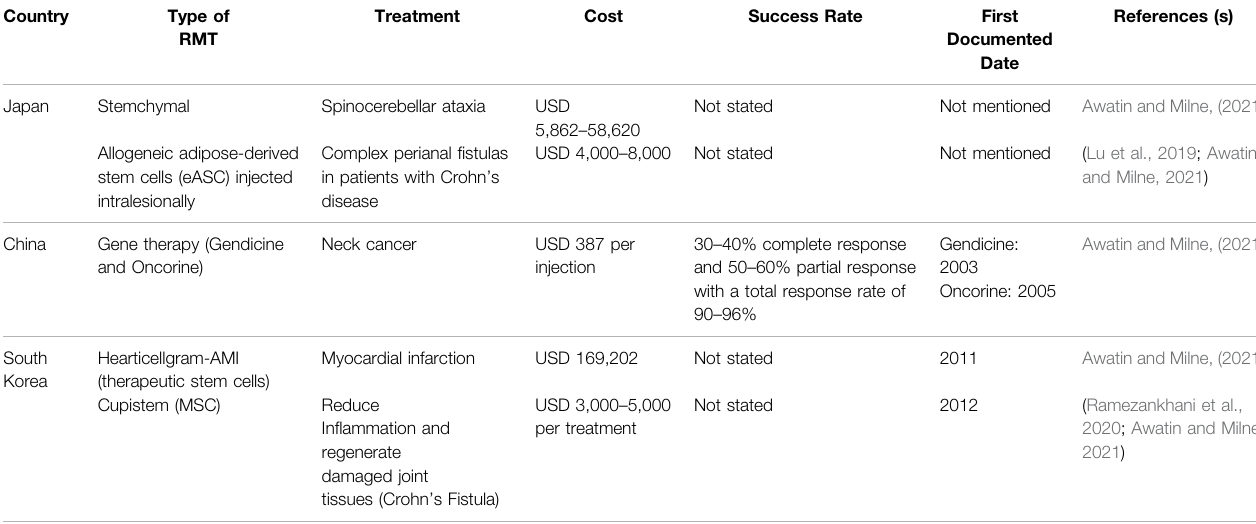
TABLE 1 | Regenerative medicine therapy in Asian countries.